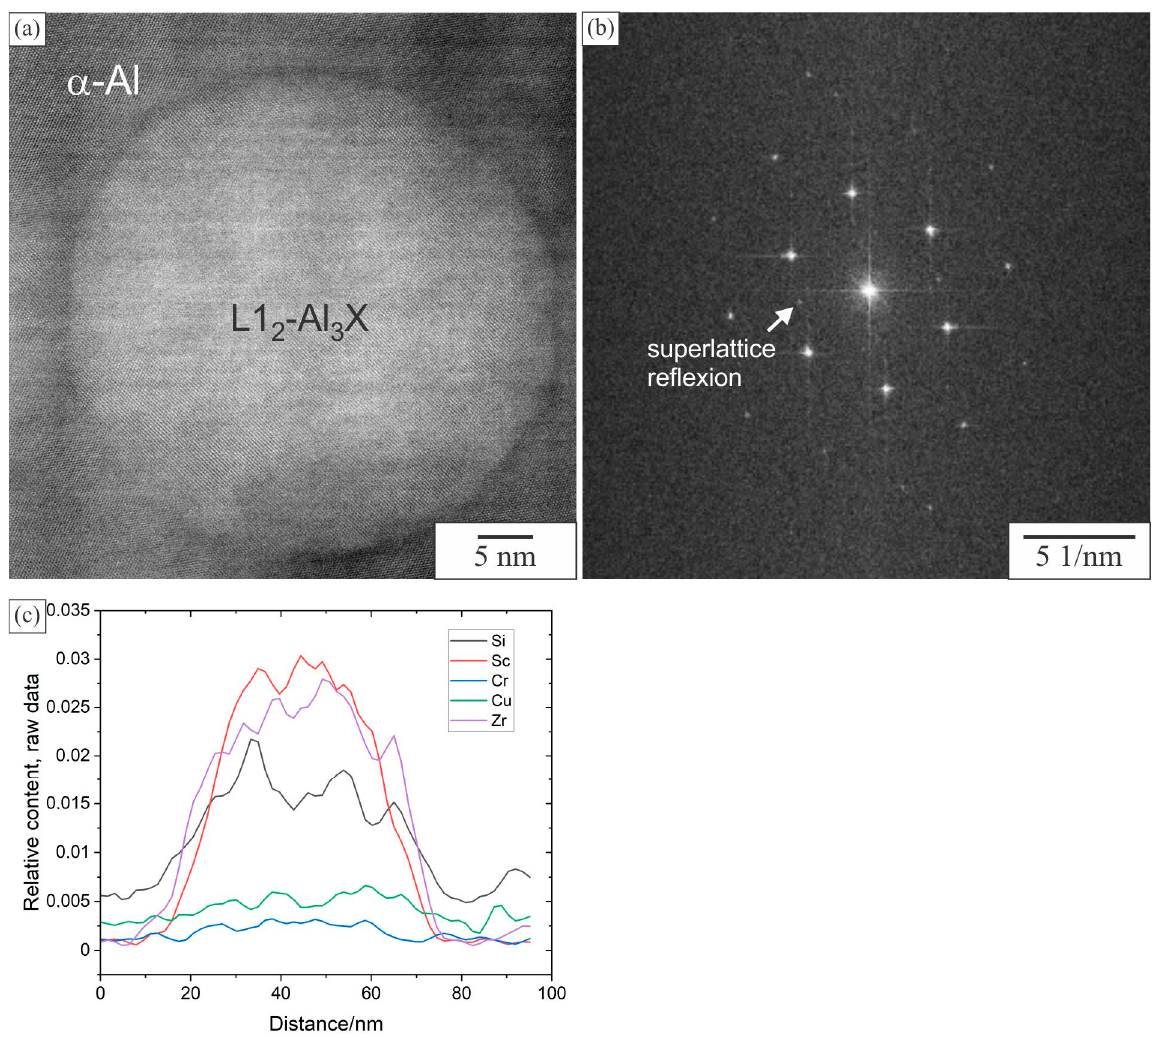
Figure 14. The results of analytical TEM of a particle with the L1 2 structure (T6 temper): ( a ) HRTEM of indicated particle, ( b ) the corresponding FFT, ( c ) EDS linescan through the L1 2 particle.